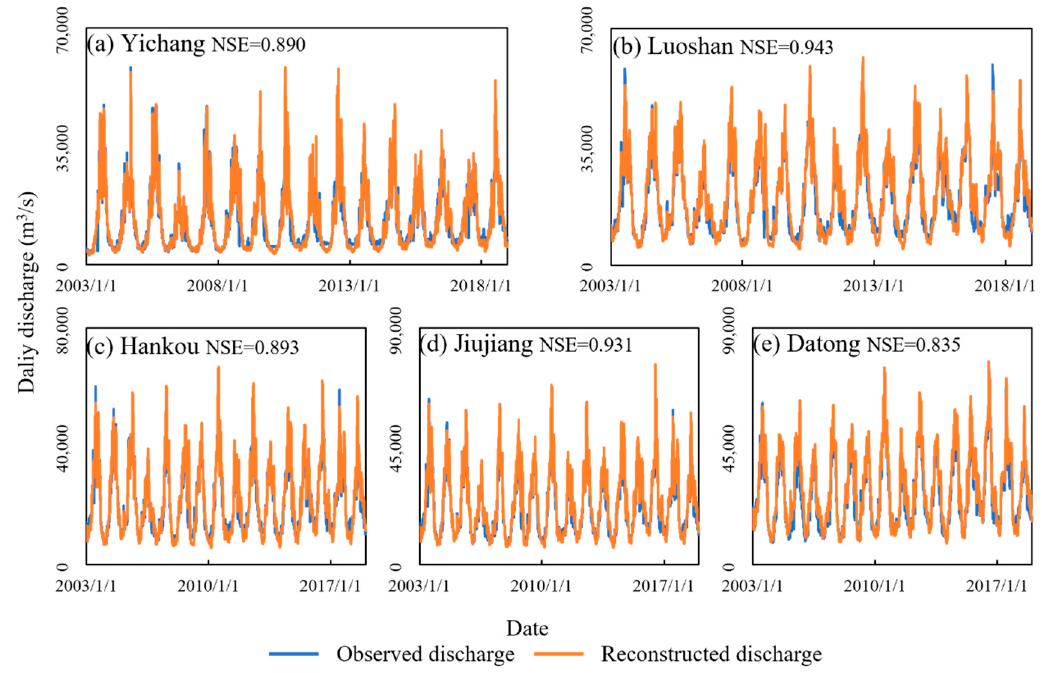
Figure 5. Simulation period from 1 January 2003 to 31 December 2018. Table 2. The Nash efficiency coefficient (NSE) of different gauging stations during different periods.